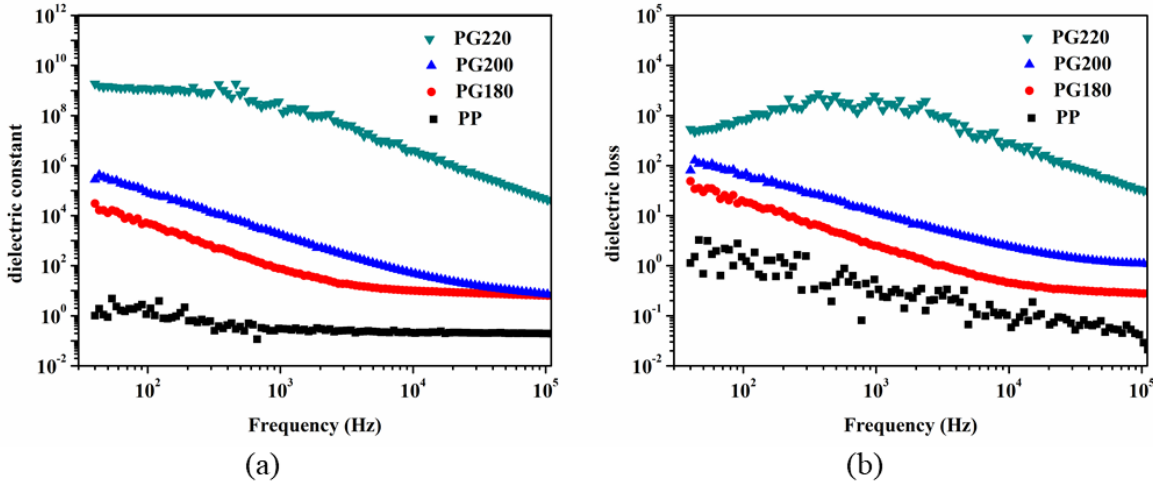
Figure 4. ( a ) Dielectric constant and ( b ) dielectric loss versus frequency for neat PP and PP/GIC composite samples.